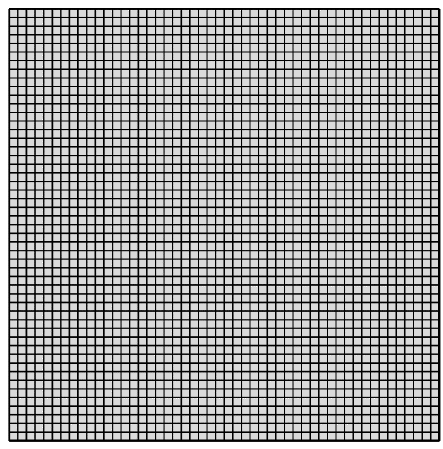
Figure 9. Finite element mesh for computational homogenization.